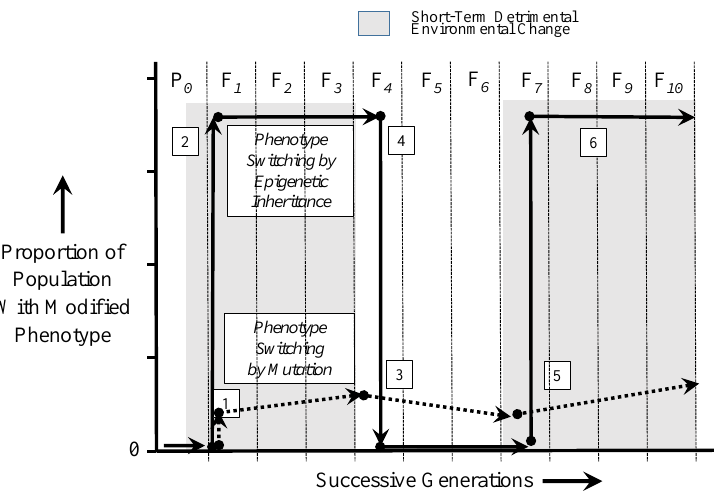
Figure 3. A comparison of phenotype switching in a population occurring by inherited point mutation vs. inheritance through the effects of epigenetic markers. Events 1, 3 and 5 indicate proportional changes in a hypothetical population resulting from phenotype switching by point mutation that are advantageous during environmental stress, but otherwise disadvantageous (or at least energetically costly). Events 2, 4 and 6 indicate proportional changes in the population resulting from epigenetic phenotype switching. See the text for an additional explanation.